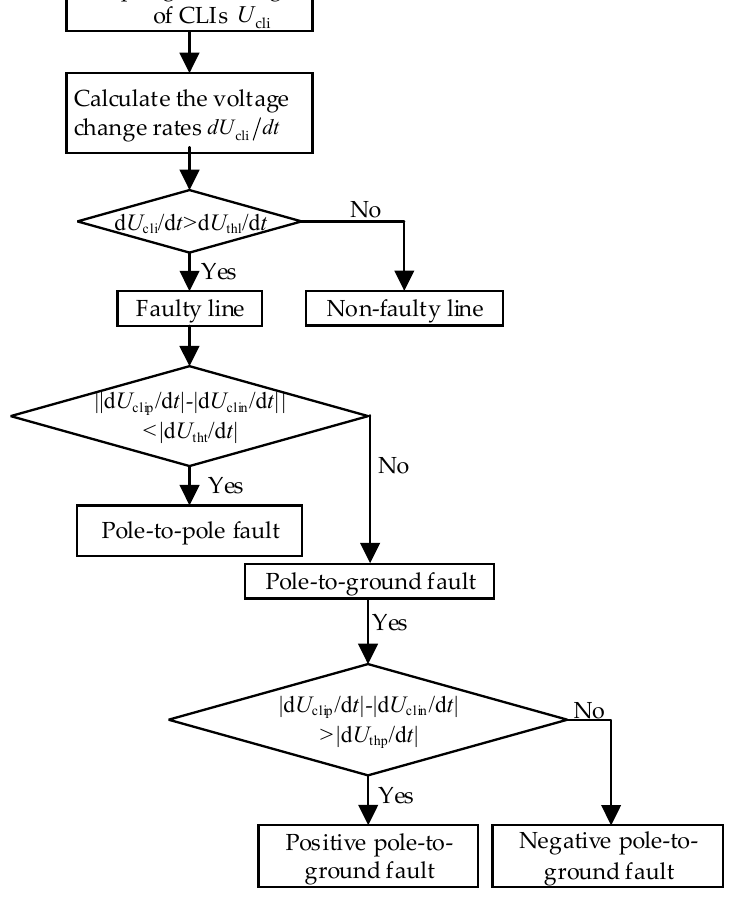
Figure 3. Flow chart of the proposed primary fault detection method for DC faults.